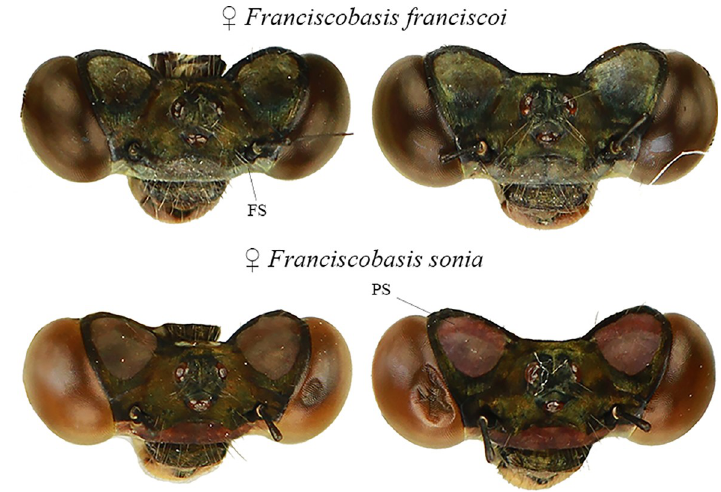
Fig 2. Coloration similarities between Franciscobasis sonia and F . franciscoi . FS: longitudinal frons stripe; PS: postocular spots.